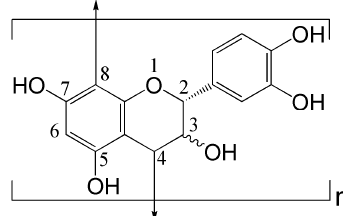
Figure 1. Representative chemical structure of flavan-3-ol unit and proanthocyanidins.